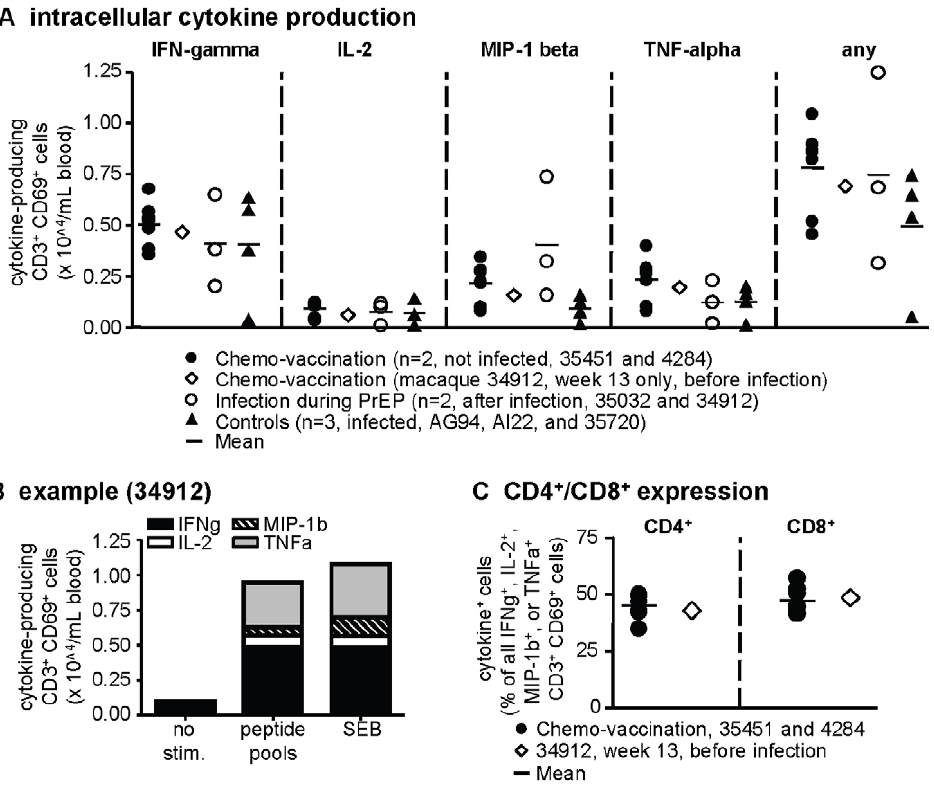
Figure 4. Cytokine production of CD4 + and CD8 + T cells induced by chemo-vaccination. Intracellular production of IFN c , IL-2, MIP-1 b , or TNF a was measured by flow cytometry after in-vitro incubation of freeze-thawed cells with the two dominant peptide pools as determined by previous IFN c -ELISPOT. We gated on CD3 + and CD69 + ( A, B ), or on CD3 + , CD69 + , and CD4 + or CD8 + ( C ), and determined the number of cells with intracellular production of any of the factors, regardless of whether they simultaneously produced the remaining 3 factors. ‘‘Any’’ refers to cells producing any of the indicated factors, not necessarily all simultaneously. Samples from infected controls or infected PrEP-treated macaques were from peak viremia or 6 weeks thereafter, whenever available. Such samples are not shown for CD4/CD8 analysis, because CD4 + cells significantly decline depending on the stage of SHIV infection. ( B ) Representative example of results obtained with cells from macaque 34912 before its infection, without stimulation (‘‘no stim.’’), with the two dominant peptide pools, or with SEB for polyclonal